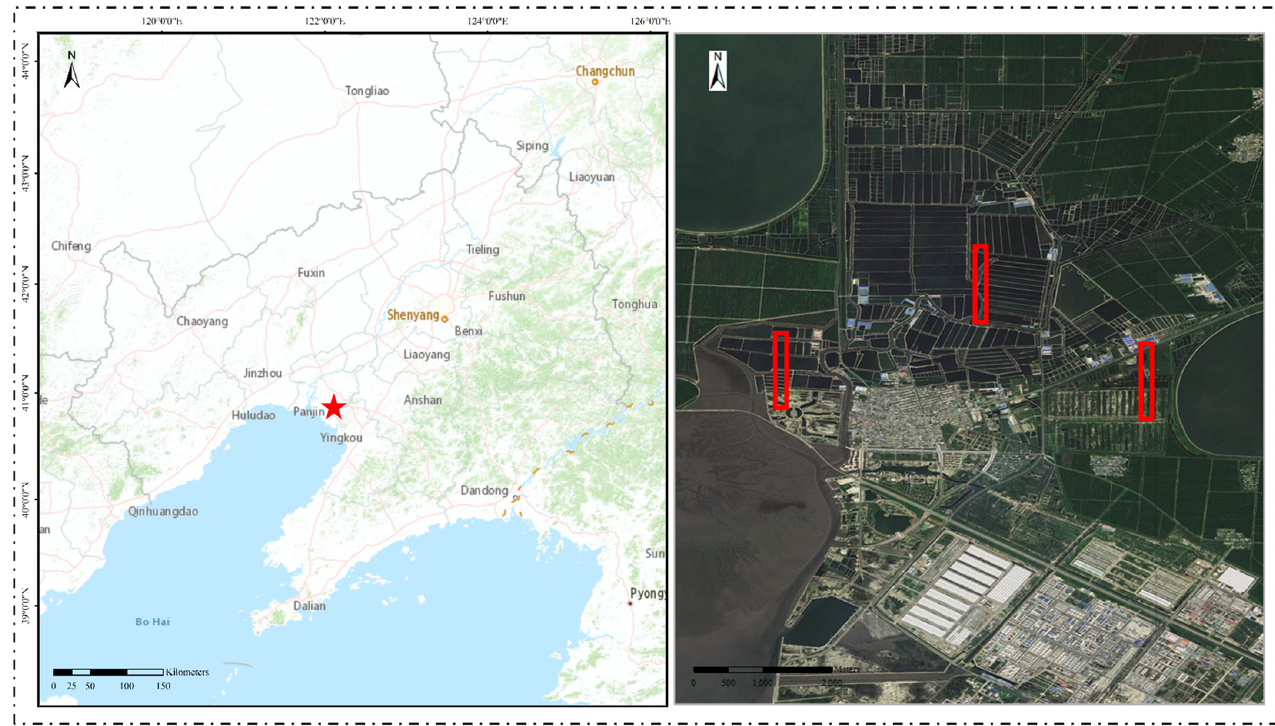
Figure 1. The location of the study area.